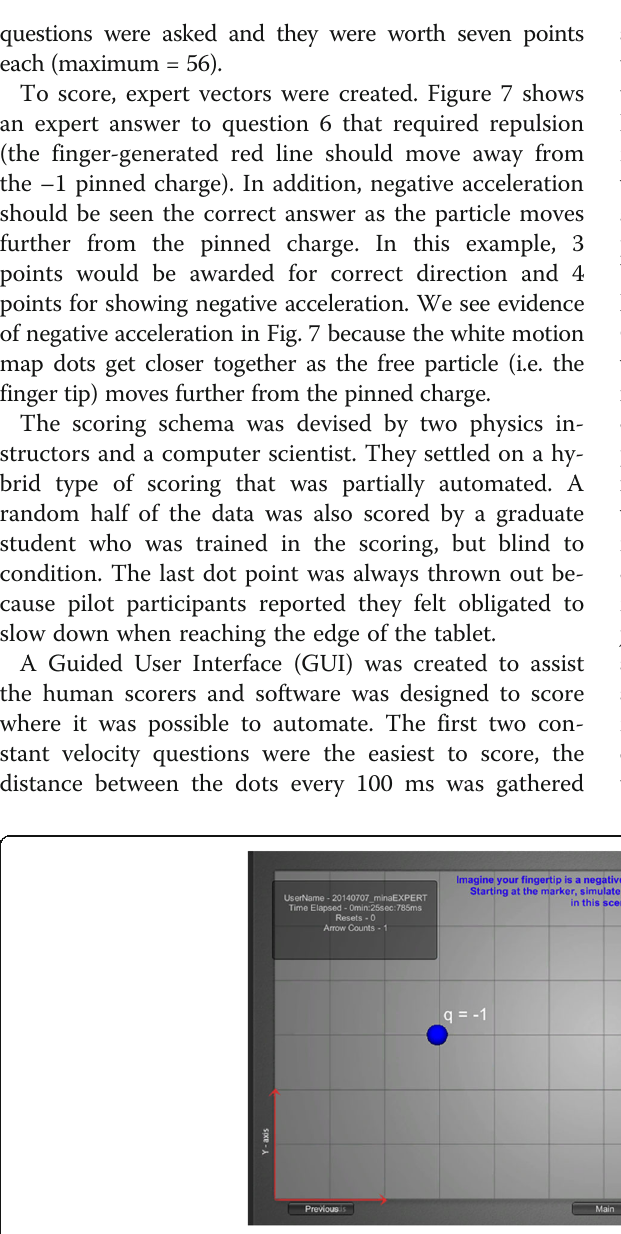
Fig. 7 Expert answer to question 6 on the Wacom